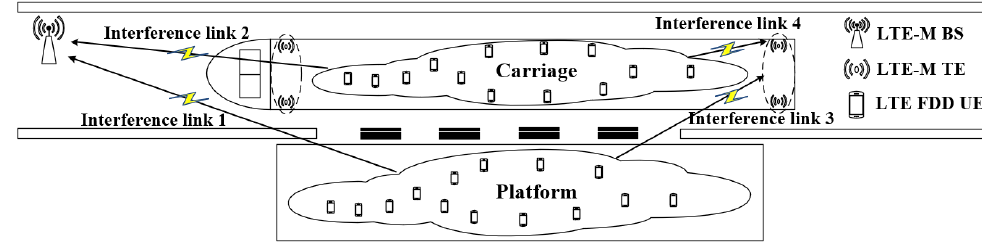
Figure 2. Interference analysis of LTE-M with directional antenna radiations pattern.